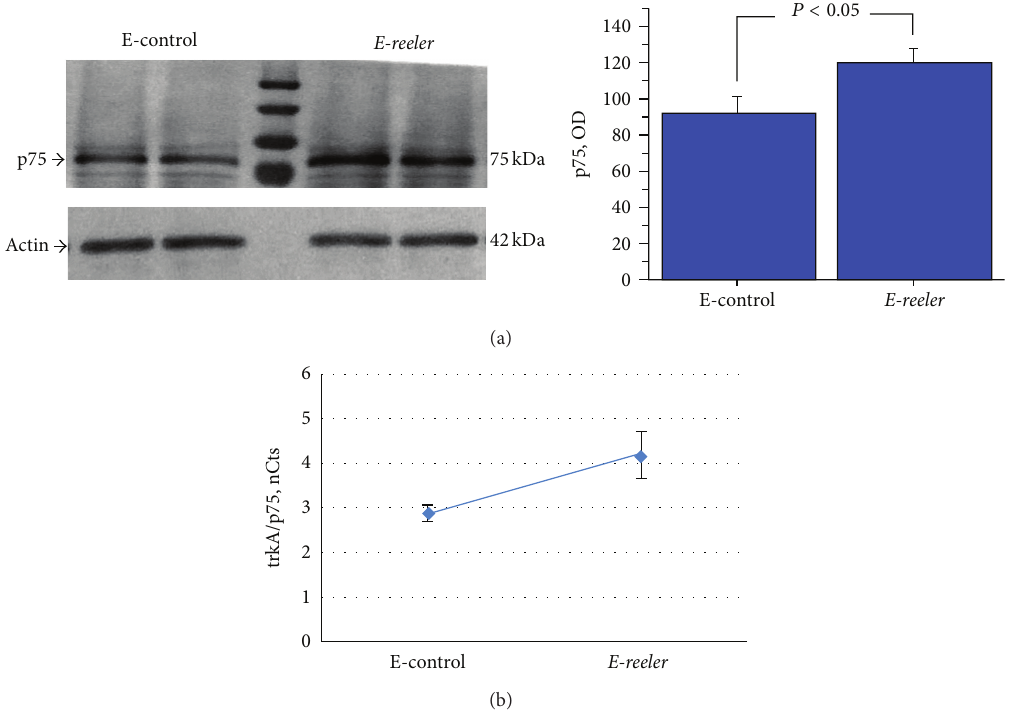
Figure 5: p 75 NTR expression in E-reeler retina. (a) Representative 7.5% SDS-PAGE and relative densitometric analysis (OD values; 𝑃 < 0.05 ), probed with p 75 NTR antibodies, showing a significant increase of p 75 NTR in E-reeler protein extracts, as compared to the E-control. (b) Scatter plot showing the correlation with the trkA NGFR /p 75 NTR ratio in the E-reeler versus E-control, highlighting a shift towards p 75 NTR expression (Tau = 0.857; 𝑃 < 0.01